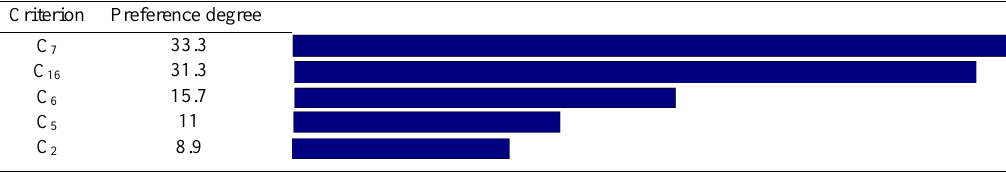
Table5. Comparison of proposed criteria importance to access the goal 20